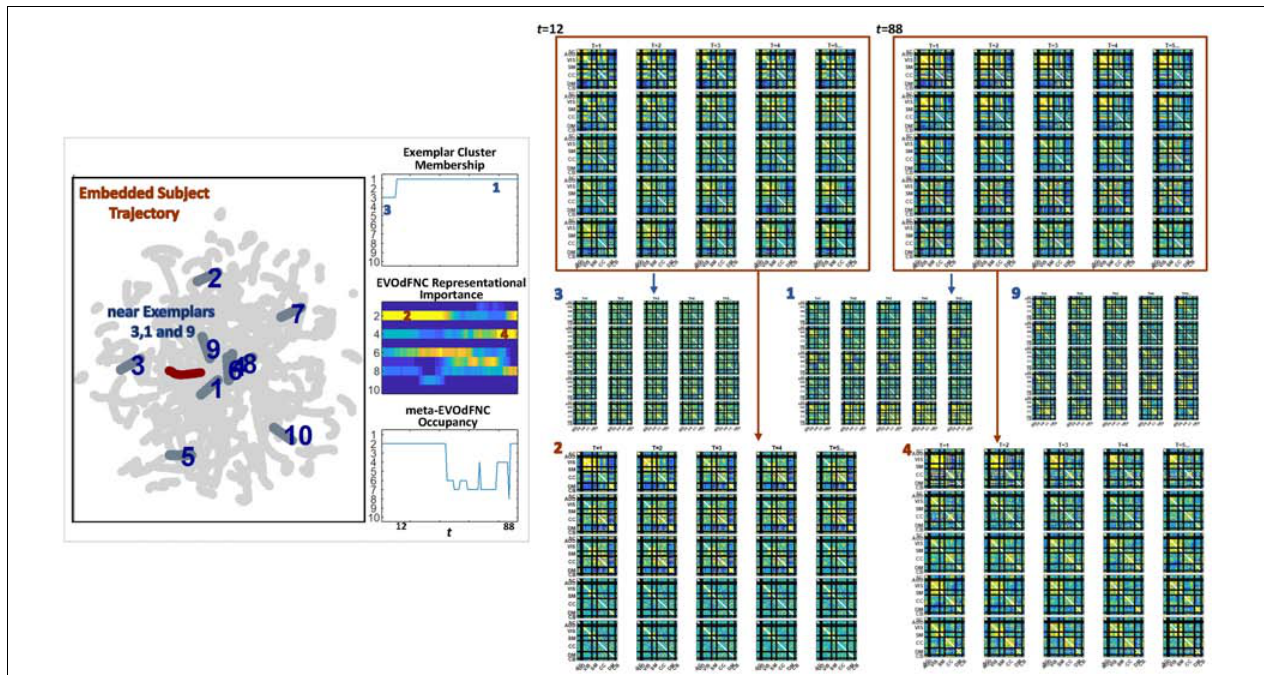
FIGURE 19 | (Leftmost panel) One subject’s embedded trajectory ˆ γ (maroon) and the 10 linear exemplars (dark gray, labeled in dark blue) shown superimposed over the full embedding (light gray). The embedded trajectory passes near exemplars 3, 1, and 9. (Left panel, column 2, top) As expected, the local linearizations approximating ˆ γ belong to clusters defining exemplar 3 and then exemplar 1, both of which ˆ γ passes close to. (Left panel, column 2, middle) The time-varying representational importance of the high-dimensional EVOdFNCs corresponding to each linear exemplars in the subject’s high-dimensional dFNC trajectory (cid:48) ; the highest RI concentrates in EVOdFNCs 2 and 4, which are lifted from exemplars 2 and 4, neither of which is proximal to ˆ γ ; EVOdFNCs 3 and 1, corresponding to exemplars 3 and 1, have very low high-dimensional RI. (Right panel, top row) windows w 12 and w 85 starting at t = 12 and t = 85, which carry high RI from EVOdFNCs 2 and 4, respectively (Right panel, middle row), EVOdFNCs corresponding to exemplars 3, 1, and 9 that ˆ γ passes close to in the plane are not highly frame-wise correlated with (cid:48)( w 12 ) or (cid:48)( w 85 ), whereas (Right panel, bottom row) EVOdFNCs 2 and 4, which are most representationally important in (cid:48) , do exhibit evidently strong framewise correlations with (cid:48)( w 12 ) and (cid:48)( w 85 )